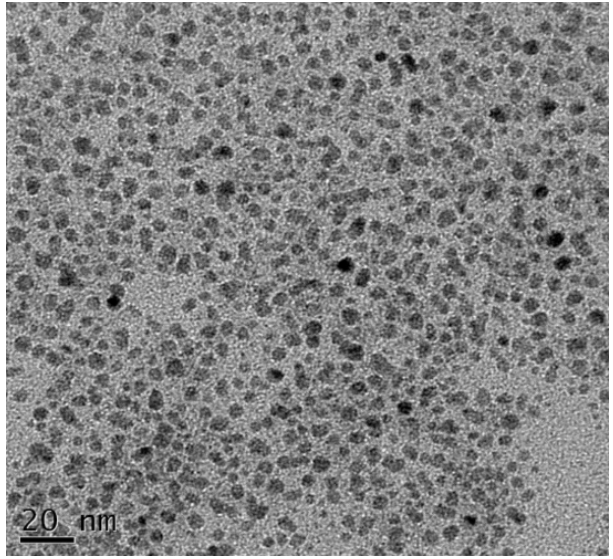
Figure 1. The size and shape of the D-limonene nanoemulsion droplets under transmission electron microscopy. Scale bar represents 20 nm.